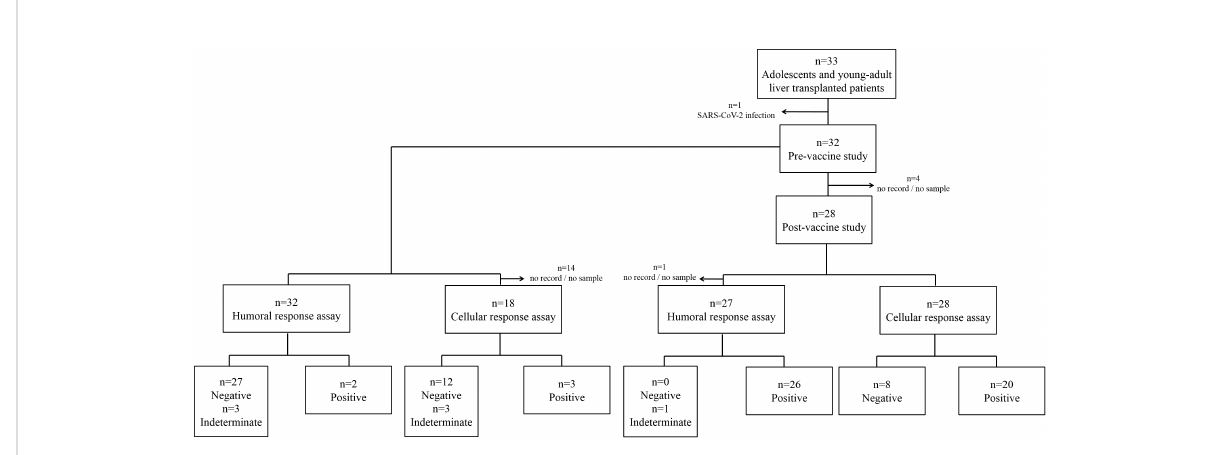
FIGURE 1 Flow diagram for the analysis of adolescent and young liver-transplanted patient cohort (n=33). First and second levels show pre- and post- vaccination groups, respectively. Levels 3-4 show the groups of humoral and cellular